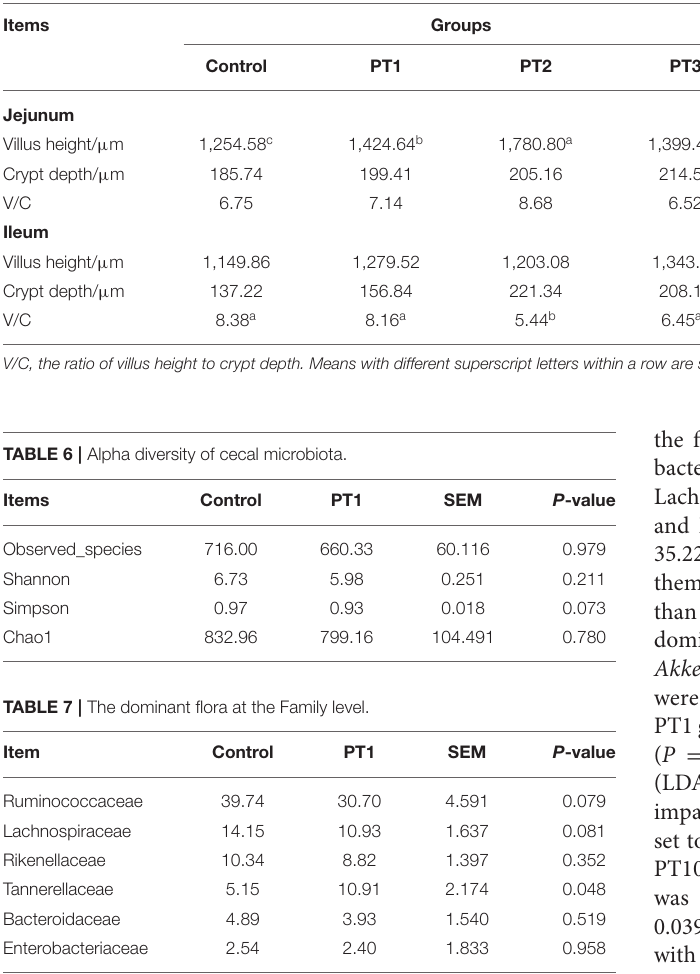
Linear Quadratic